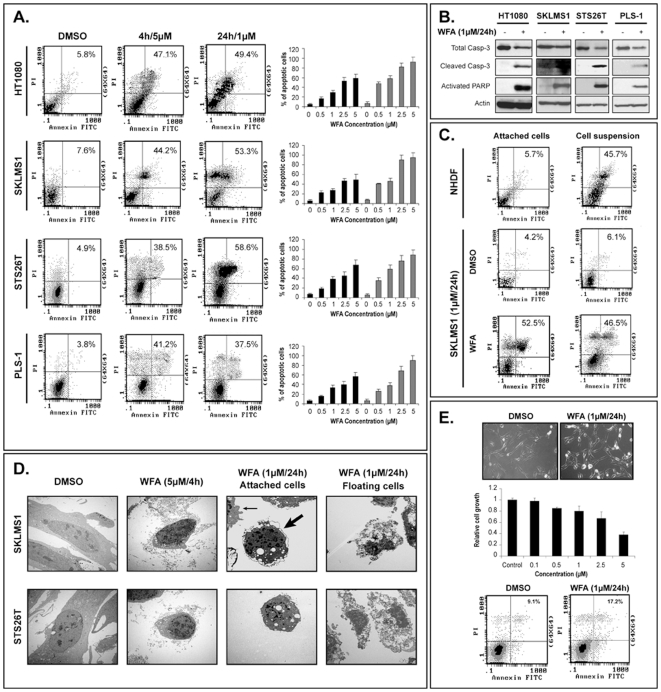
WFA induces marked apoptosis in STS cells.
A) Annexin-V/FACS analyses demonstrating marked WFA-induced apoptosis in STS cells (black bars represent 4 h of WFA treatment and gray bars represent 24 h); B) WFA (1 µM/24 hr) induces caspase-3 (Casp-3) cleavage and PARP activation in STS cells (WB analysis); C) STS cells are resistant to anoikis as compared to normal human dermal fibroblasts (NHDF). WFA (1 µM/24 hr) induces apoptosis in both attached and floating STS cells; D) Transmission electron microscopy (TEM) photographs depicting STS cell apoptosis (large arrow–nuclear condensation, small arrow–cytoplasmic blebbing) in response to WFA. Necrosis is demonstrated in floating STS cells; E) NHDF are more resistant to the effects of WFA (IC50: 3.7 µM±0.15) as compared to STS cells. Graphs represent the average of three repeated experiments ±SD.